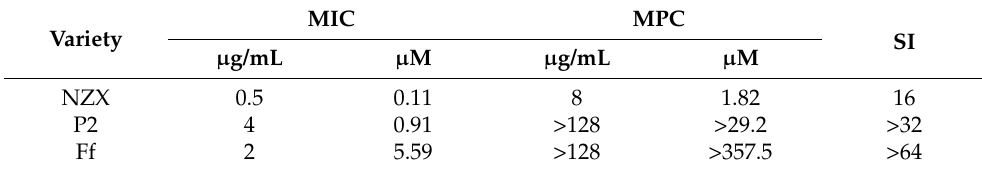
Table 2. The MIC, MPC and SI of NZX and P2 against S. agalactiae ACCC 61733.